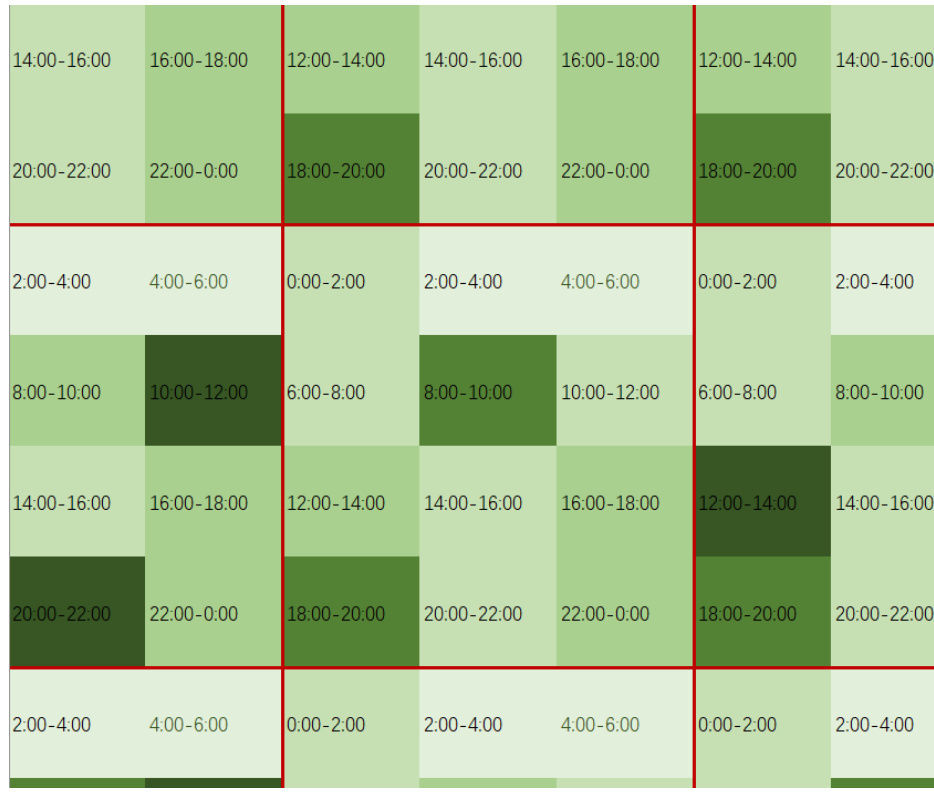
Figure 9 Calendar map-2